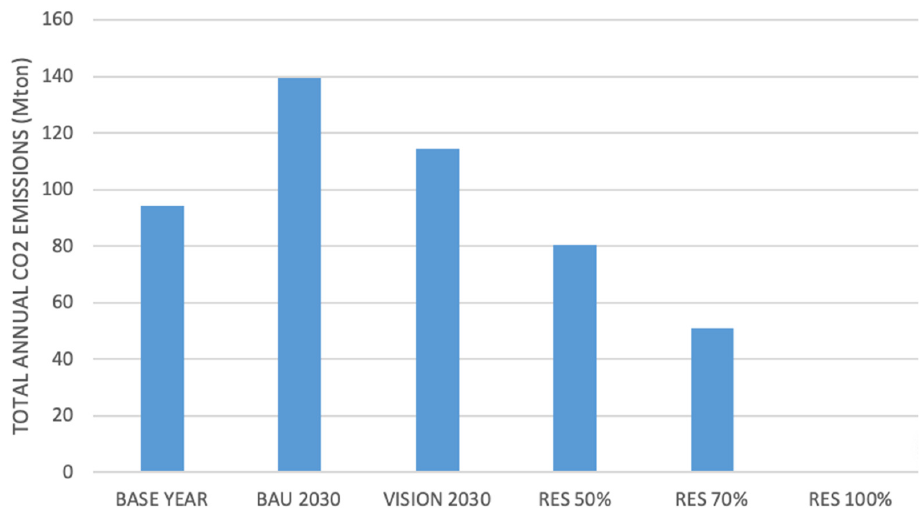
Figure 13. Total annual CO 2 emissions in 2019 and in 2030.